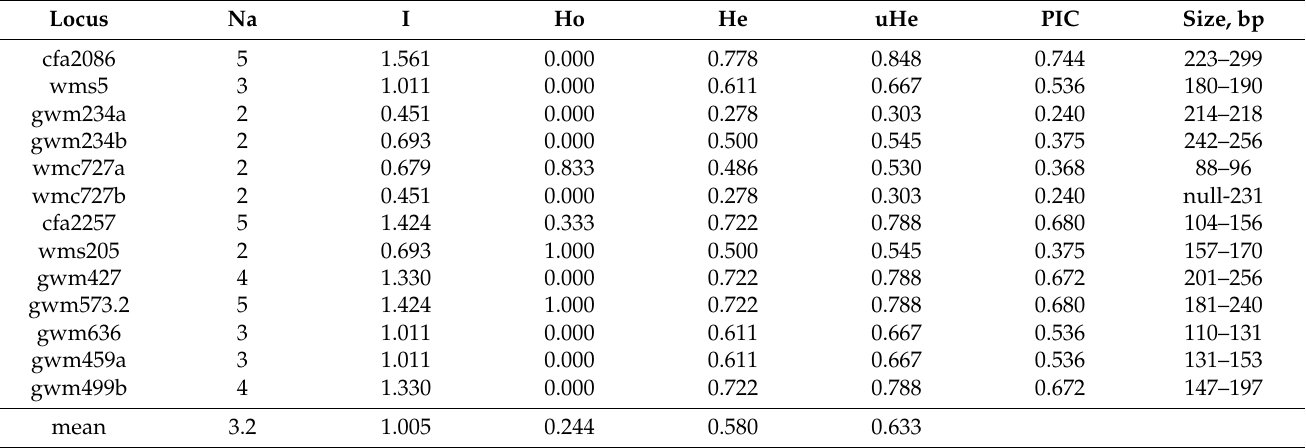
Table 4. Genetic diversity in durum wheat based on 11 SSR markers identifying 13